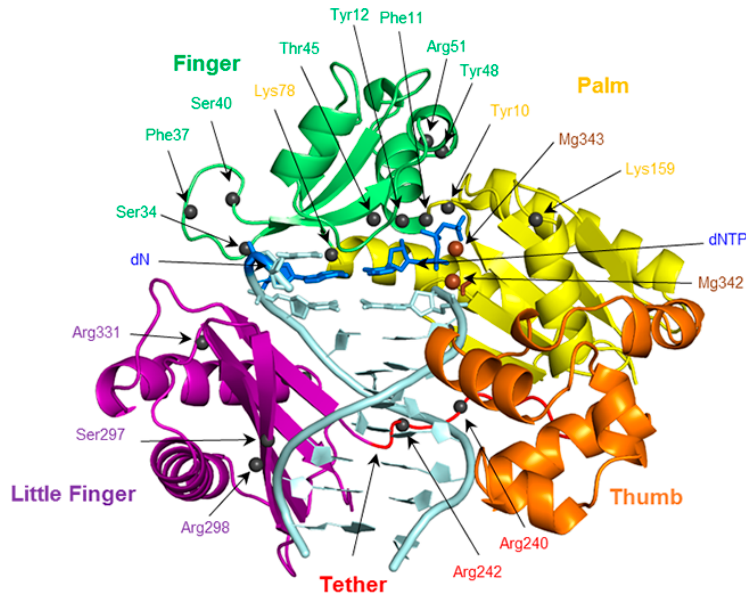
Figure 2. The finger, palm, thumb, and little finger domains of Dpo4, as well as the tether region. The positions of potentially important residues in each domain are indicated with spheres.